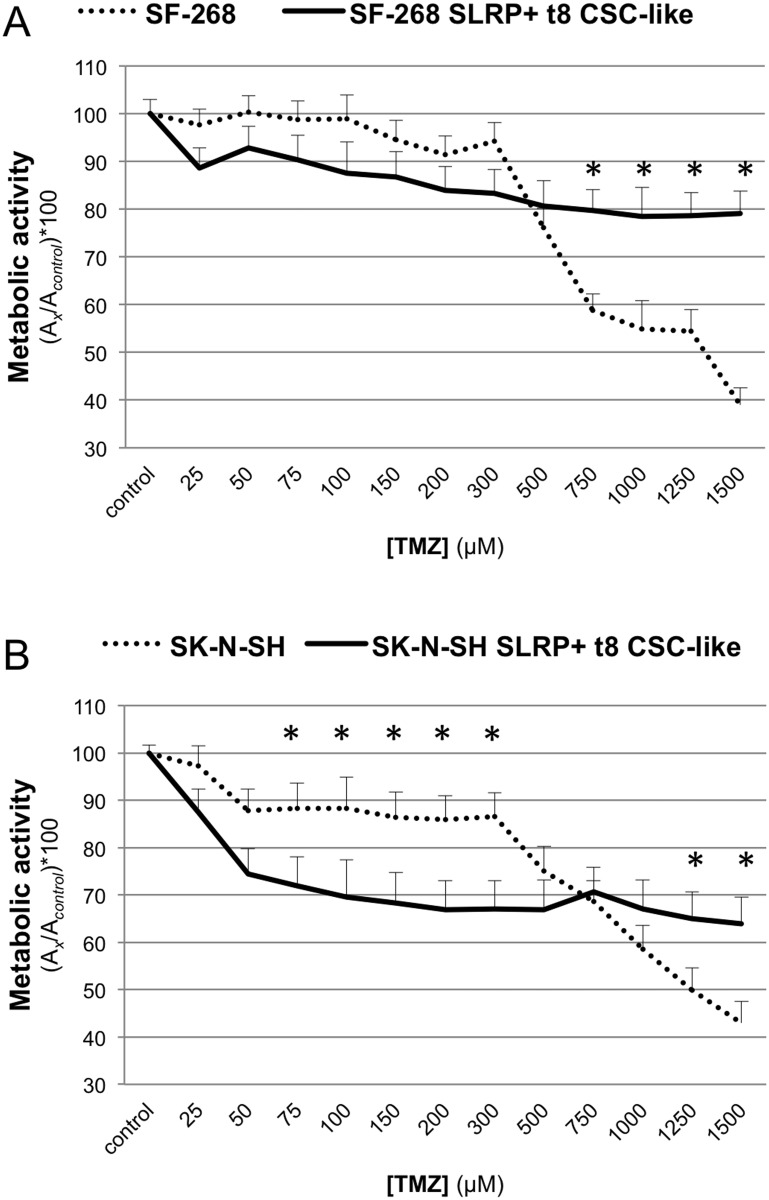
MTT assay after TMZ treatment.(A) SF-268 adherent cells versus SF-268 SLRP+ t8 CSC-like. (B) Adherent SK-N-SH cells versus SK-N-SH SLRP+ t8 CSC-like. Cell growth inhibition by low doses of TMZ (0–500 μM) was greater in the t8 CSCs-like than in the parental cell lines, with significance in SK-N-SH cells (*p < 0.05, Fig 5B). In contrast, cell growth inhibition by high doses of TMZ at, corresponding to pharmacological doses (> 750 μM), was greater in the parental cells than in the t8 CSCs-like cells in the CSC enrichments of both cell lines (*p < 0.05, Fig 5A and 5B). DMSO background was subtracted from samples and control values, and data shown as mean (SD) of [(Asamples—ADMSO) / (Acontrol—ADMSO)]*100 of four independent experiments.